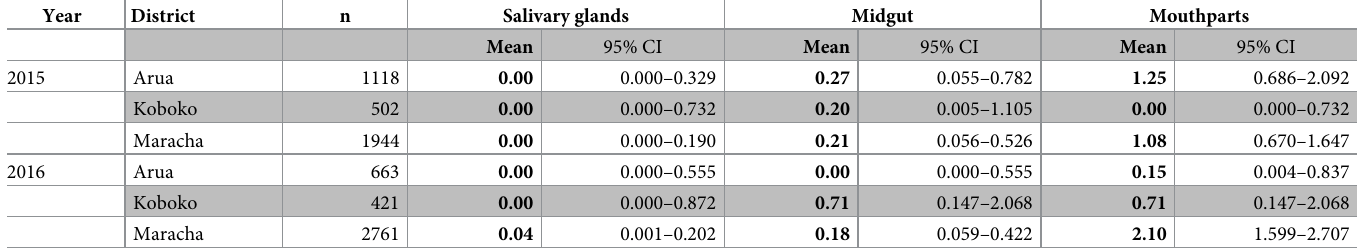
Table 1. Percentage of tsetse captured in 2015–2016 with trypanosomes observed in salivary glands, midgut or mouthparts from areas with targets present (Koboko, Maracha) or absent (Arua). Year District